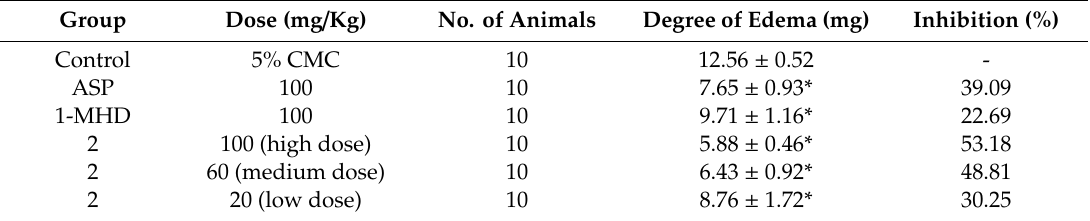
Table 2. E ff ects of di ff erent drug on the xylene induced ear edema in Table 2. Effects of different drug on the xylene induced ear edema in mice.